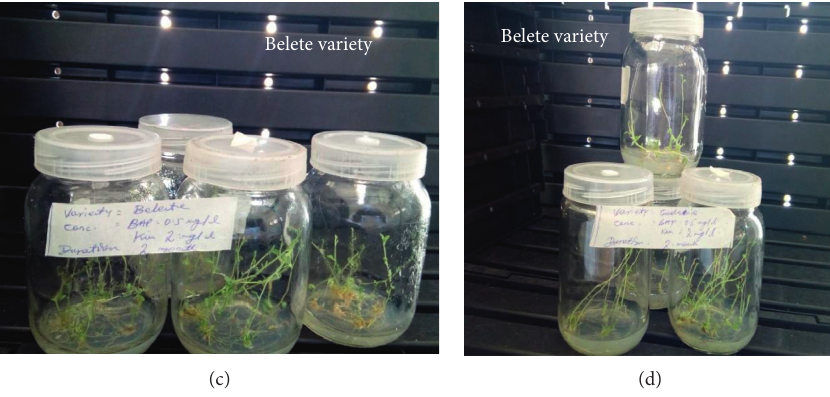
Figure 2: Shoot multiplication in Gudiene and Belete varieties of